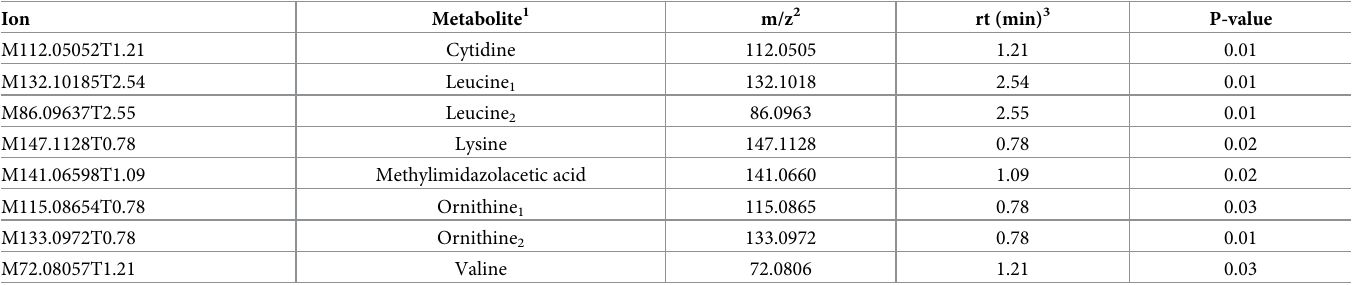
Table 3. Metabolites identified through ion annotation and further confirmed by standards which were affected (raw-P < 0.05) by residual feed intake class (Low vs High) in beef heifers.